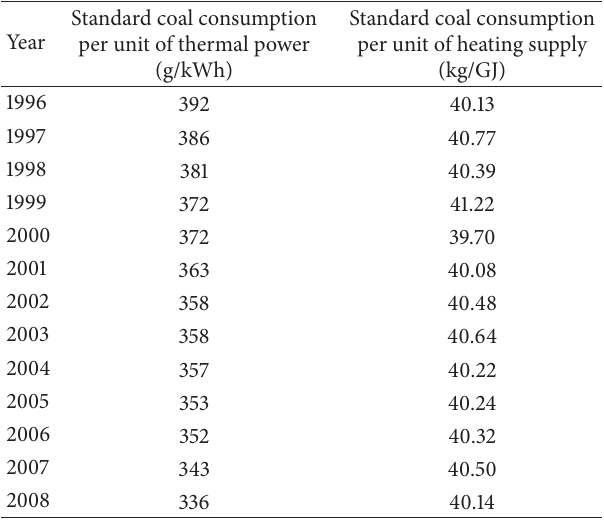
Table 3: Standard coal consumption per unit of thermal power and heating